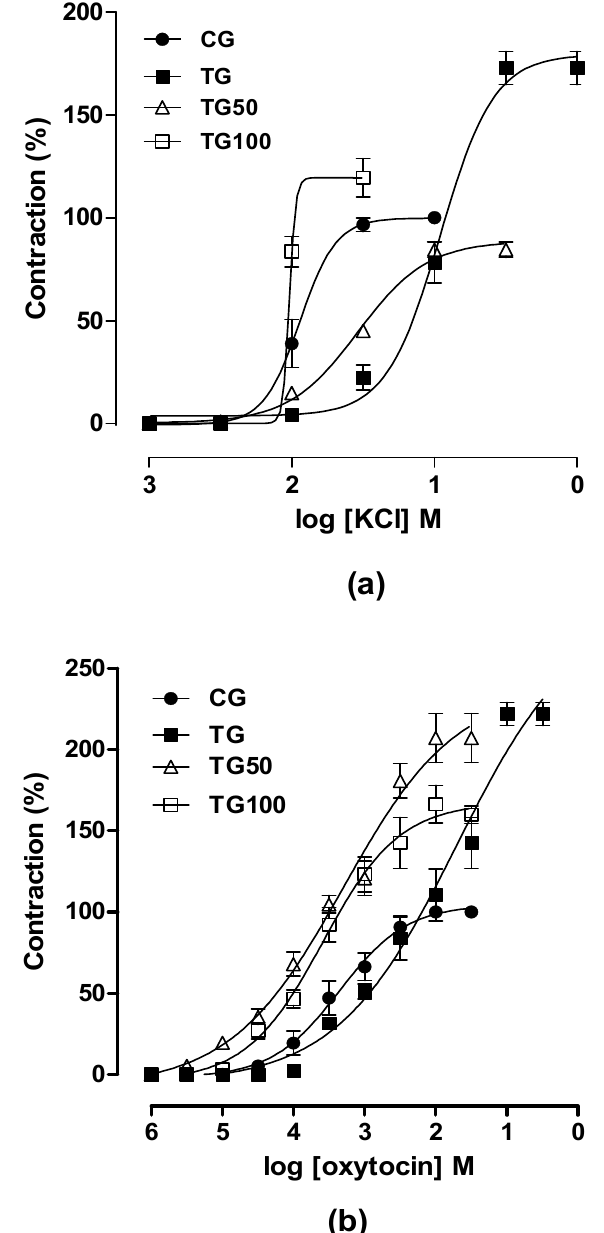
Figure 1. Effect of strength training and food supplementation with S. platensis on the cumulative concentration–response curves to KCl ( a ) and oxytocin ( b ) in isolated rat uterus, in CG ( • ), TG ( (cid:4) ), TG50 ( ∆ ) and TG100 ( (cid:3) ).The symbols and vertical bars represent the mean and the e.p.m., respectively ( n = 5). ANOVA one-way followed by Tukey’s post-test. In female rats submitted to strength training, there was a reduction in potency and an increase in the contractile efficacy of oxytocin (pCE 50 = 2.1 ± 0.1; E max = 222.0 ± 7.1%) compared to the CG (pCE 50 = 3.4 ± 0.2; E max = 100.0%) and food supplementation with S. platensis in GT50 (pCE50 = 3.5 ± 0.1; E max = 207.2 ± 15.0%) and in GT100 (pCE 50 = 3.5 ± 0.1; E max = 169.1 ± 7.7%) partially prevented the increase in efficiency and reduced the potency of this agonist (Figure